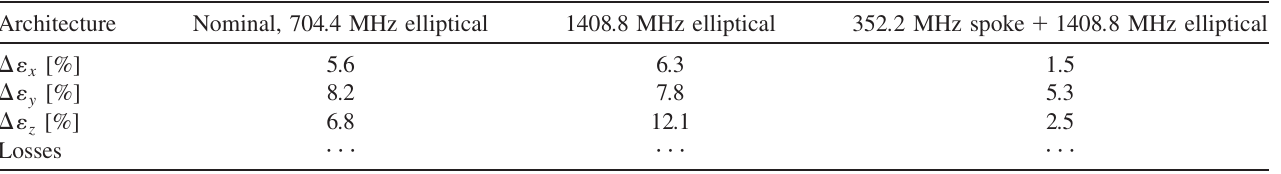
TABLE V. Emittance growth for a matched beam in the three SPL layouts. Architecture Nominal, 704.4 MHz